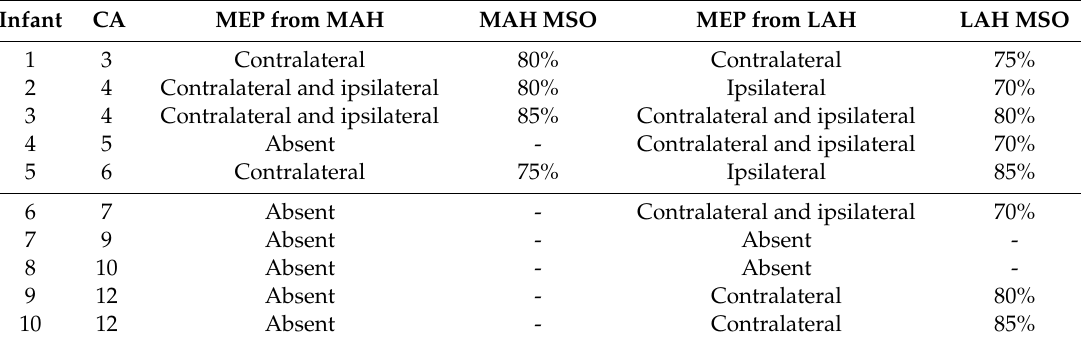
Table 3. Individual infant MEP responses to transcranial magnetic stimulation